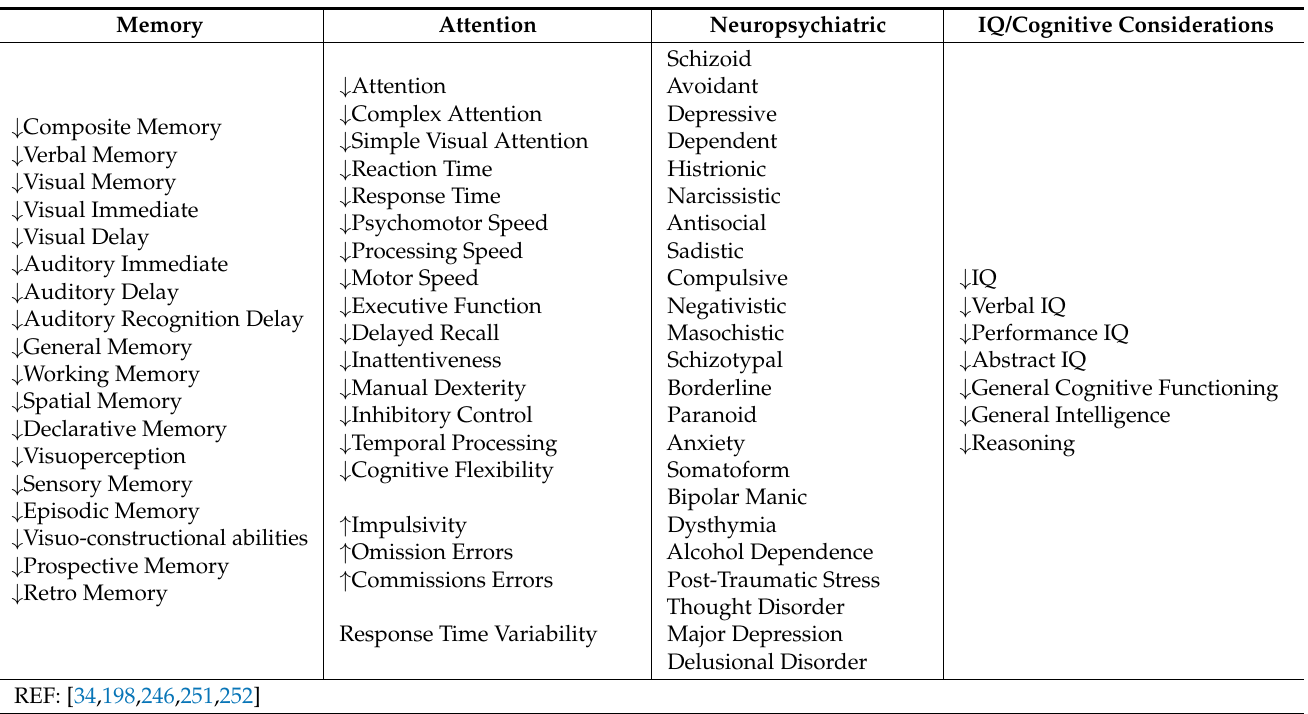
Table 5. Neuropsychiatric consequences of SUD.